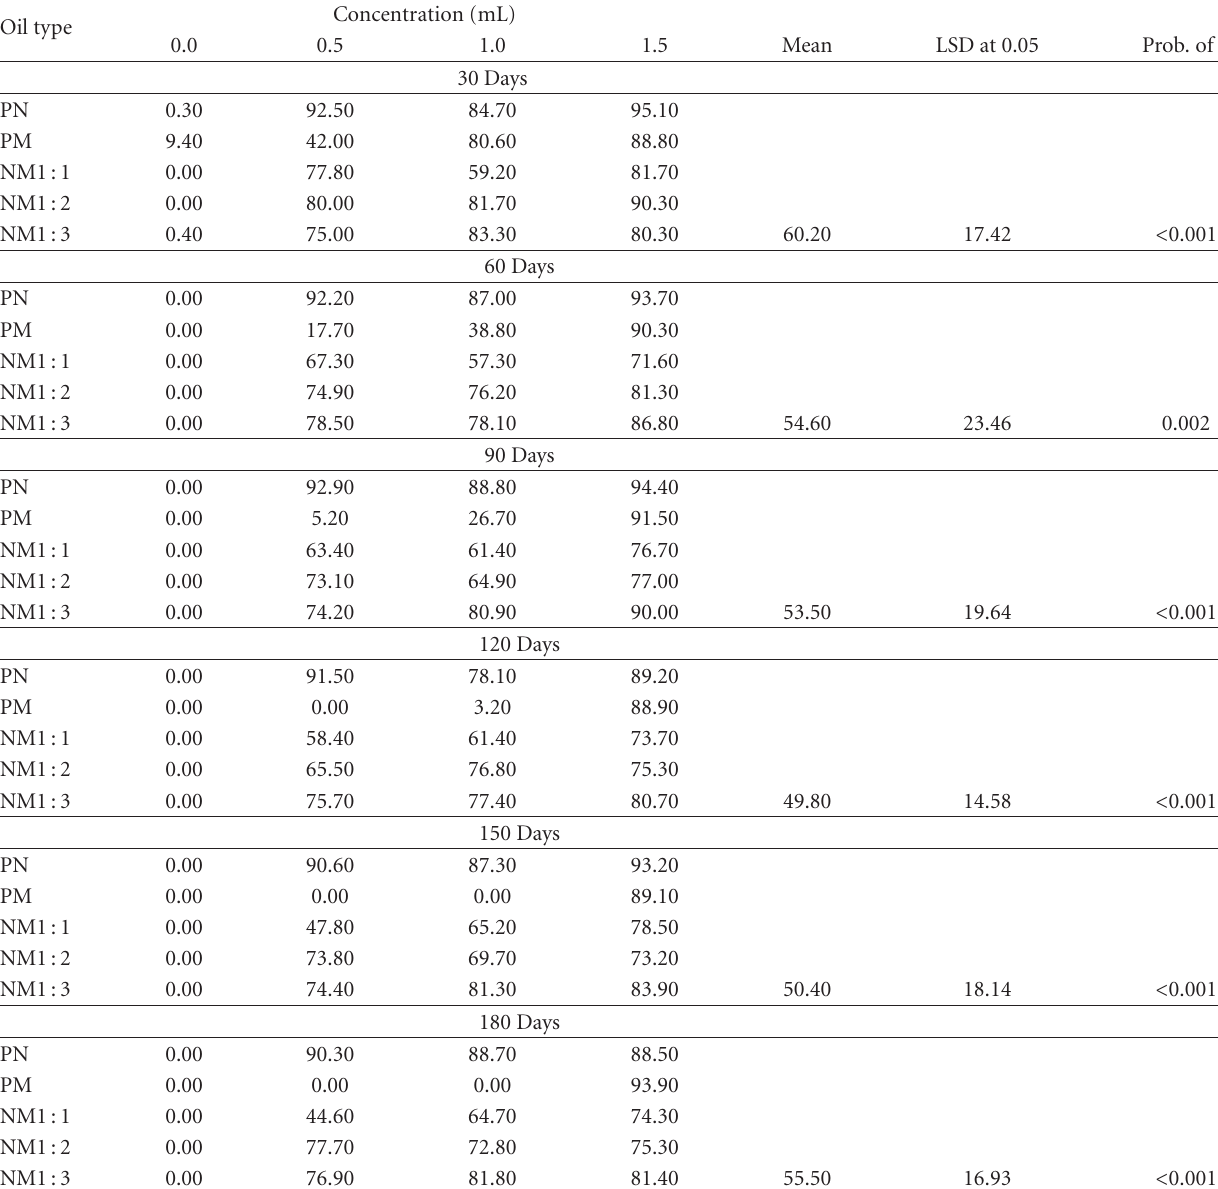
Table 3: Interaction e ff ects of oil types and various concentrations of the oils on the percentage of uninfested cowpea after di ff erent storage